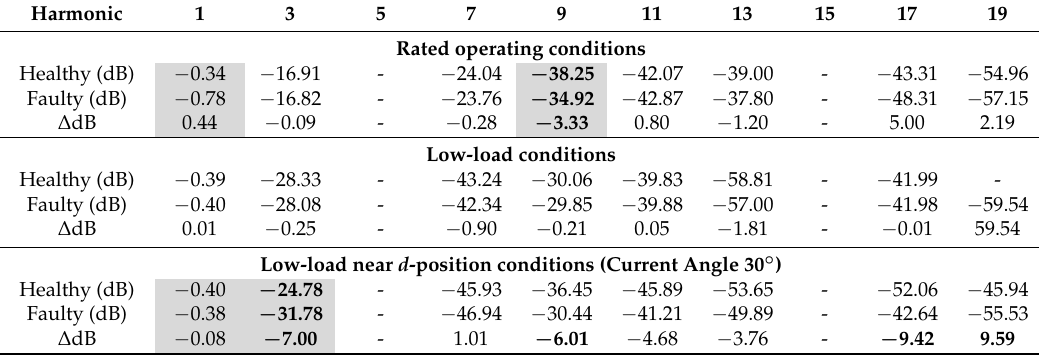
Table 2. Spectral content of the stator currents of the analyzed fPMa-SynRM under healthy and 40% static eccentricity conditions.